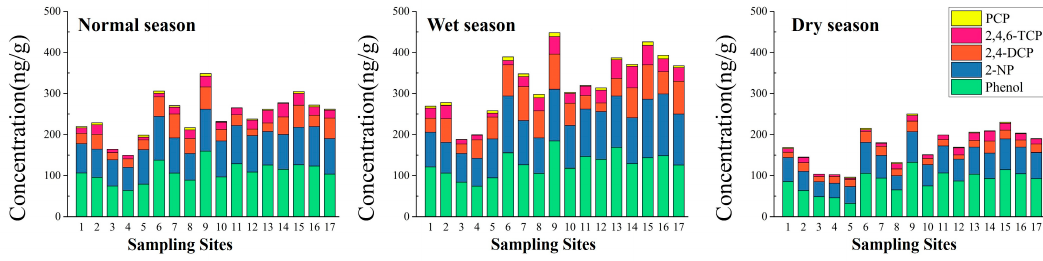
Figure 4. Spatial and seasonal distributions of concentrations of five phenolic compounds in sediment from different sampling sites of the Yinma River Basin.